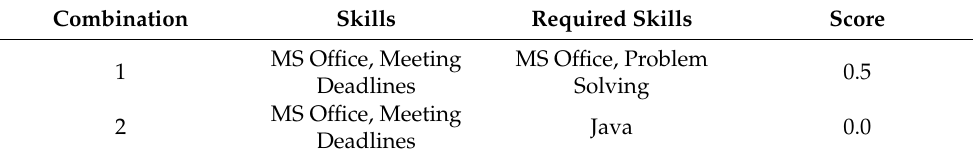
Figure 12. CQ_05: Which job posts match the migrant’s skills? Table 7. Skills’